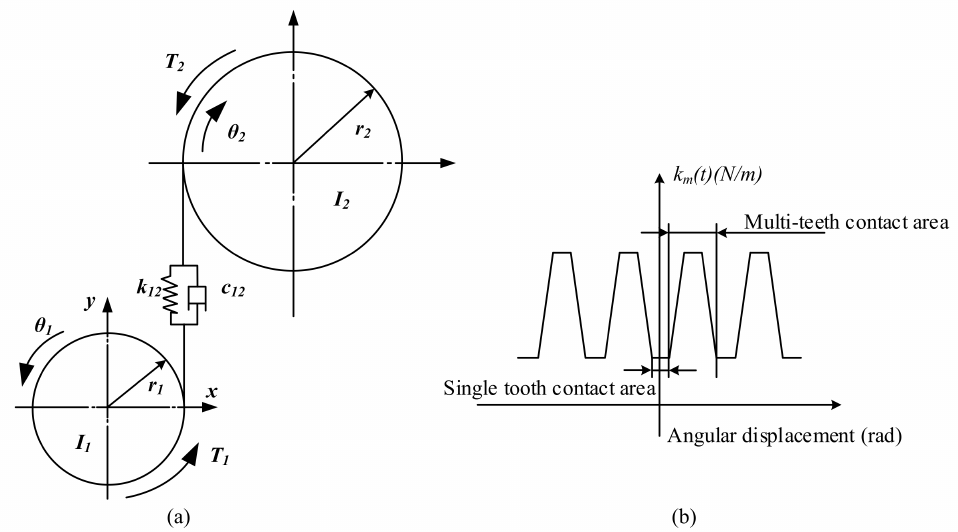
Figure 2. Dynamic model of gear system: ( a ) Dynamic model of gear pair; ( b ) Schematic diagram of time-varying meshing stiffness of